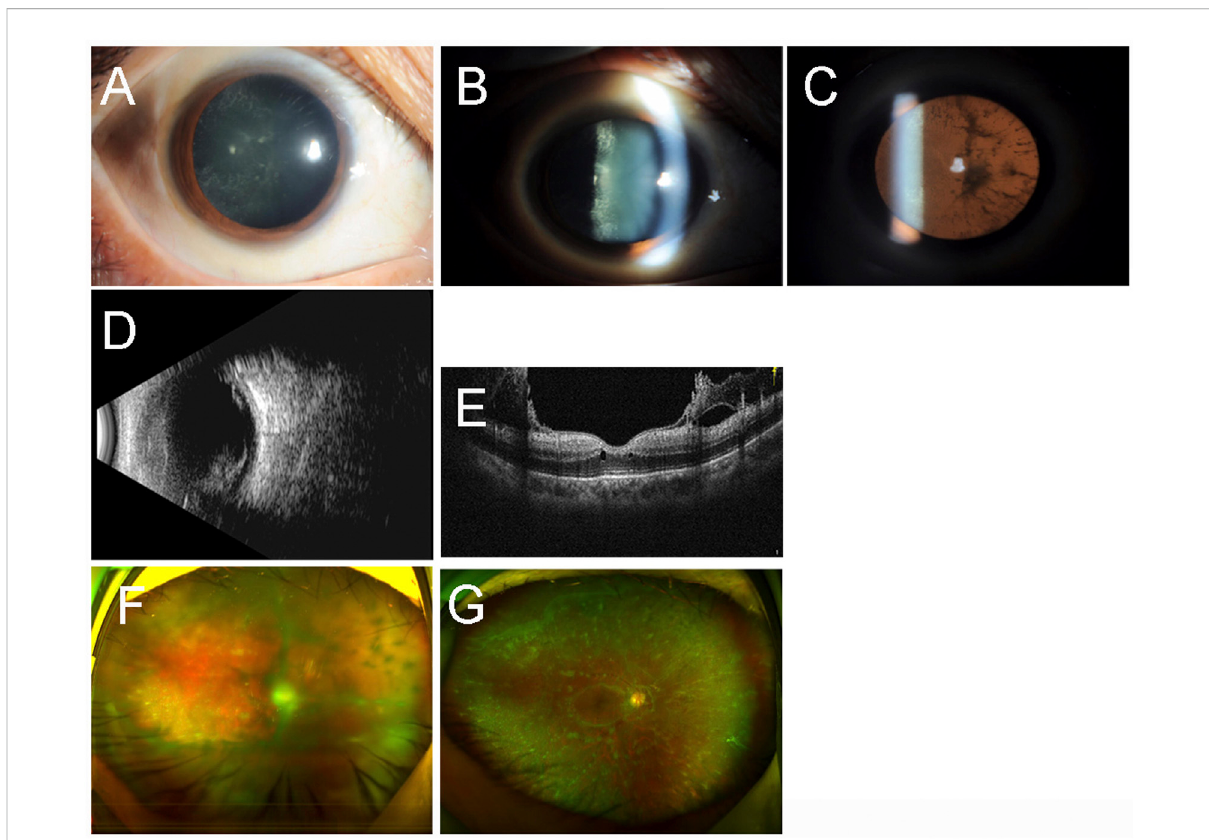
FIGURE 1 Ocular imaging fi ndings of the right eye of the proband (III-13). Slit-lamp examination (A – C) revealed amyloid deposition in the posterior lens capsule. B-mode ultrasonography (B) showed mass echoes in the vitreous cavity. Ocular coherence tomography (E) con fi rmed the glasswool-like posterior vitreous cortex attached to the retina. Ultra-wide- fi eld scanning laser ophthalmoscopy revealed vitreous opacities before the surgery (F) and one month after the surgery (G)